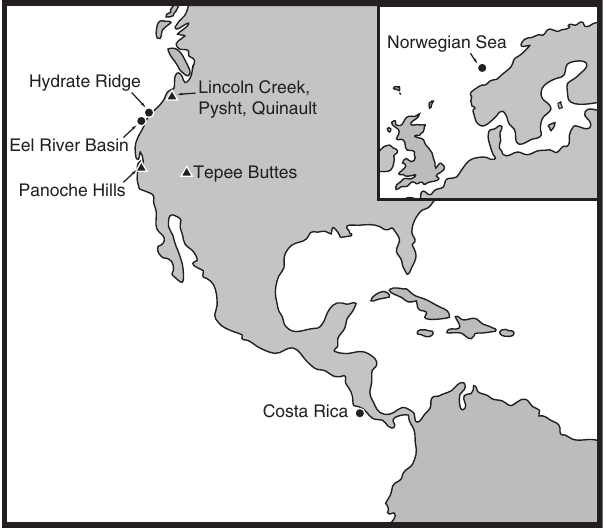
Figure 1 | Map of sample sites. Circles and triangles correspond to modern and ancient seep sites,